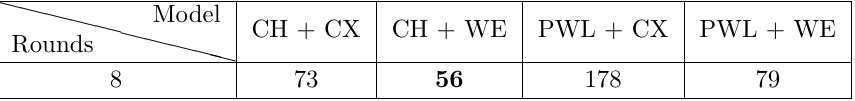
Table 8: Solving times for LED over 8 rounds depending on the modeling. Timings are given in seconds, over a subset of all cases, and normalized by deducing the time spent on the pairs reaching the time